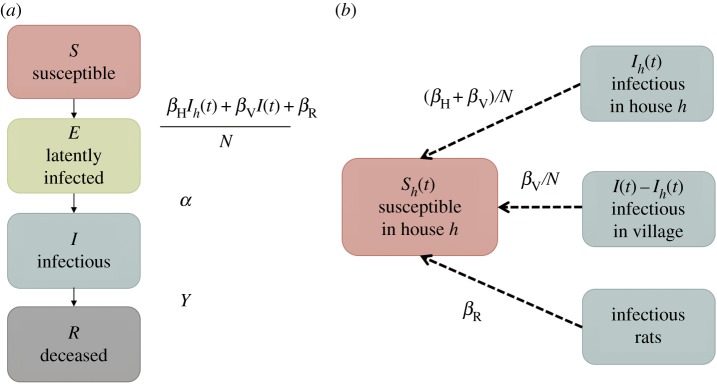
(a) Flow diagram of model compartments with rates of transition between infection states for an individual in house h. (b) Diagram showing routes of plague transmission to a susceptible individual in house h. (Online version in colour.)